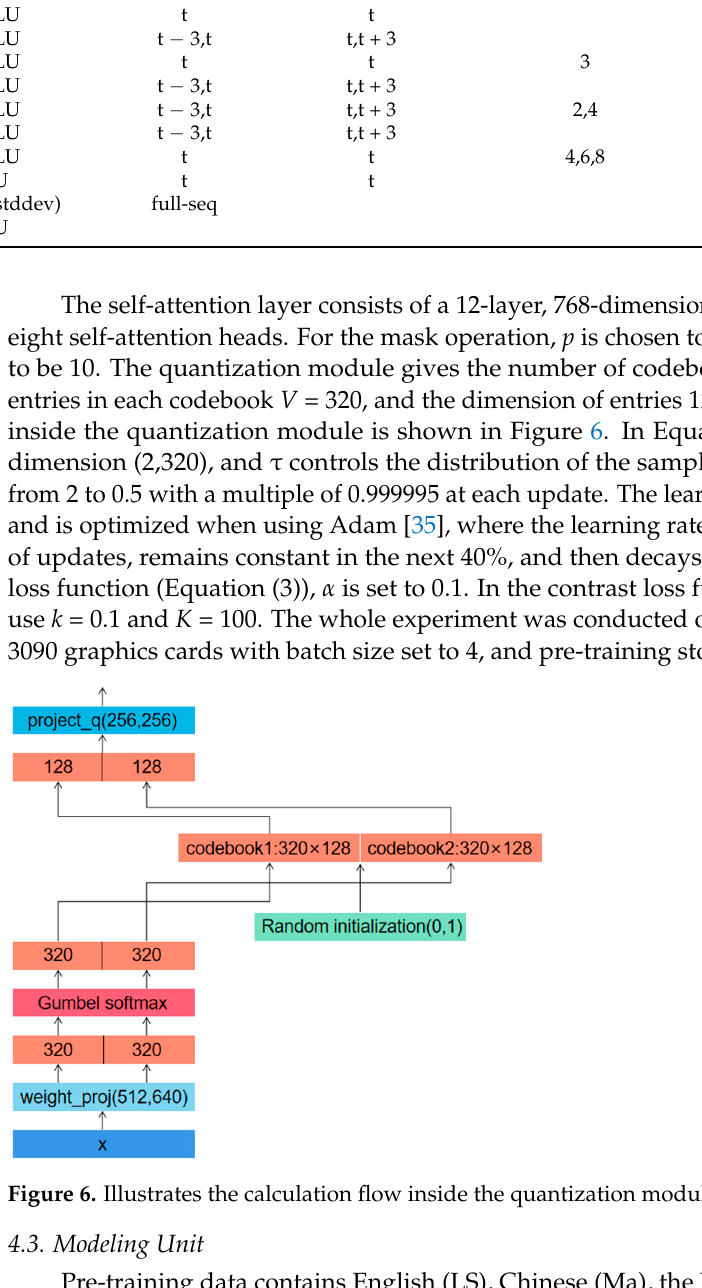
Table 3. Specification of data sets for each language.